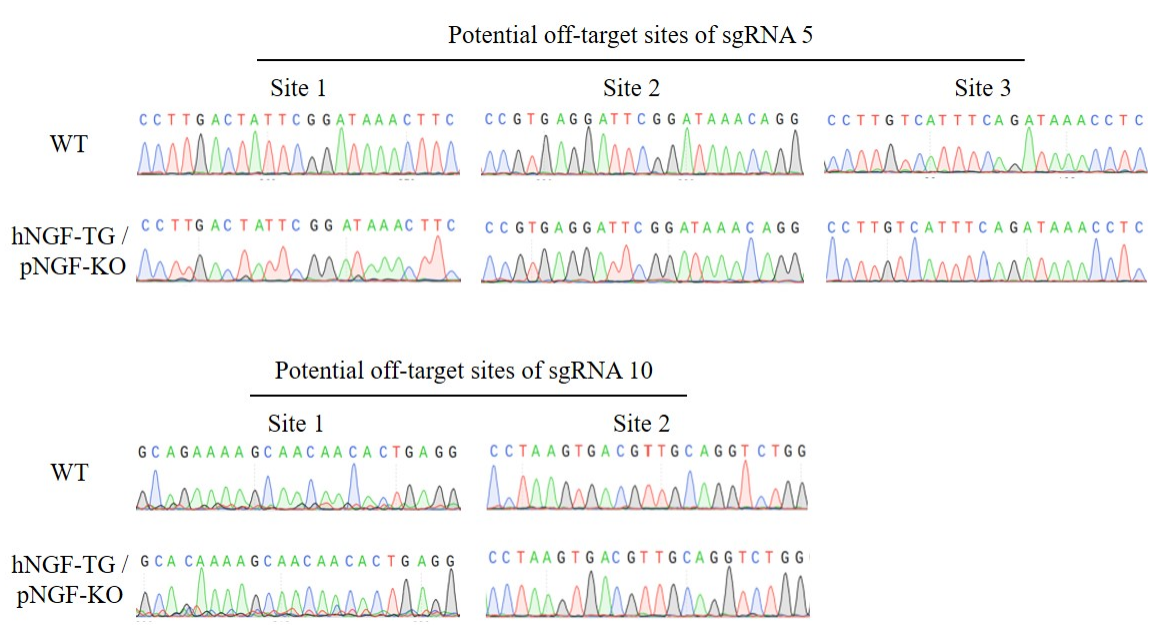
Figure 8. Off-target analysis of double-transgenic hNGF-TG/pNGF-KO fibroblast cell colonies. Table 3. Summary for production of double ‐ transgenic hNGF ‐ TG/pNGF ‐ KO pigs. Table 3. Summary for production of double-transgenic hNGF-TG/pNGF-KO